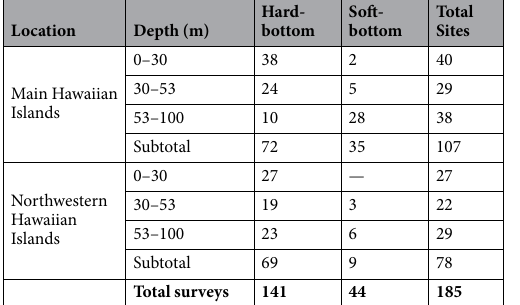
Table 1. Summary of sampling effort in the Hawaiian Archipelago, detailing the number of sites per region, depth strata, and habitat